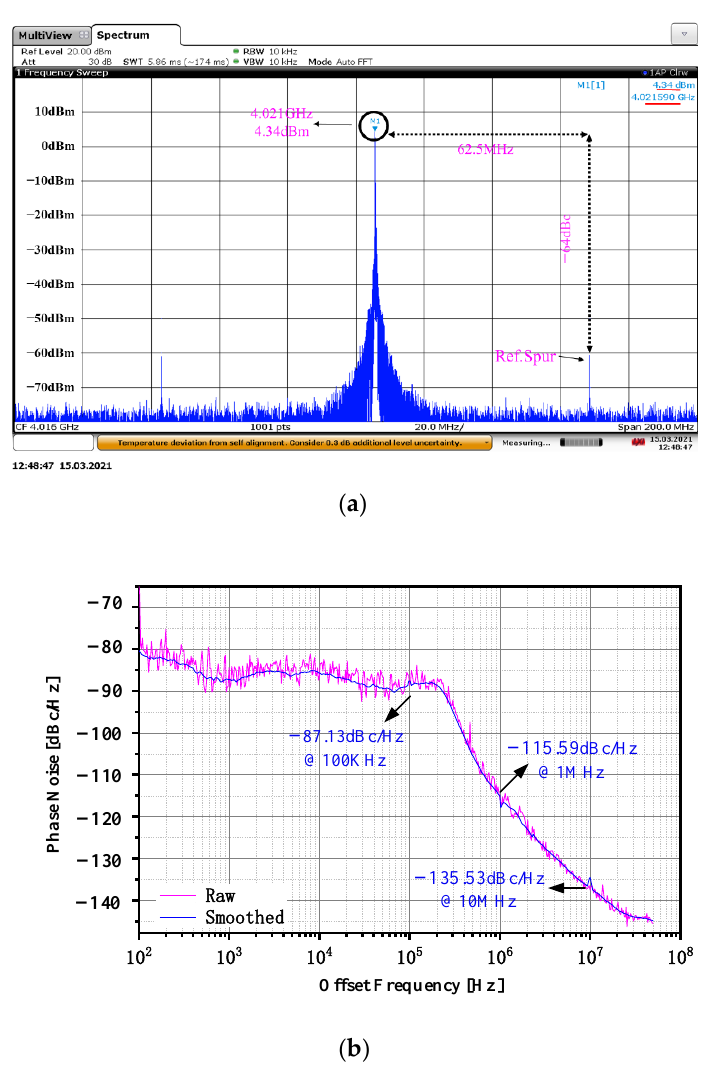
Figure 12. The test results when the output signal is 4.021 GHz: ( a ) the frequency spectrum; ( b ) the phase noise.